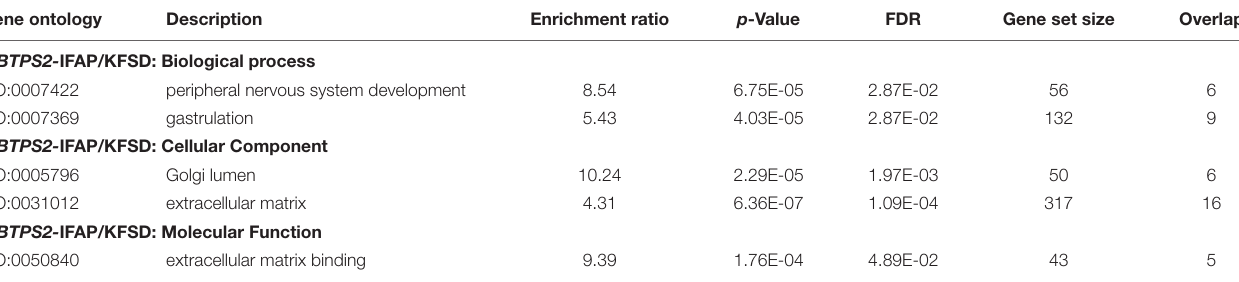
TABLE 2 | Over-represented GO terms amongst the DEGs in MBTPS2 -IFAP/KFSD vs. controls. Gene ontology Description Enrichment ratio p -Value FDR Gene set size